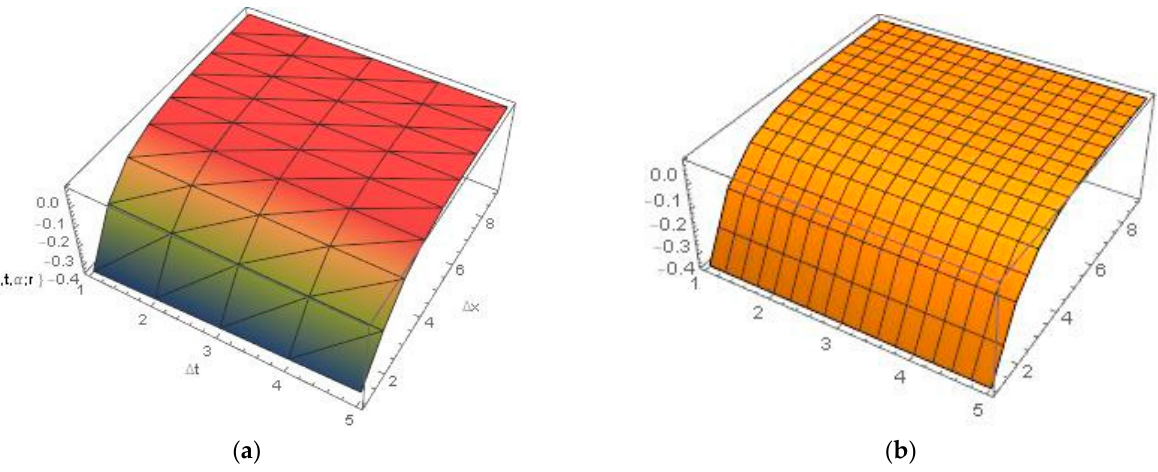
Figure 2. ( a ) Lower numerical solution of Equation (30), by explicit finite difference, ( b ) Lower exact solution at 𝑡 = 0.05,𝑥 = 4 , 𝛼 = 0.9 and 𝛽 = 0 for all 𝑟 ∈ [0,1] .